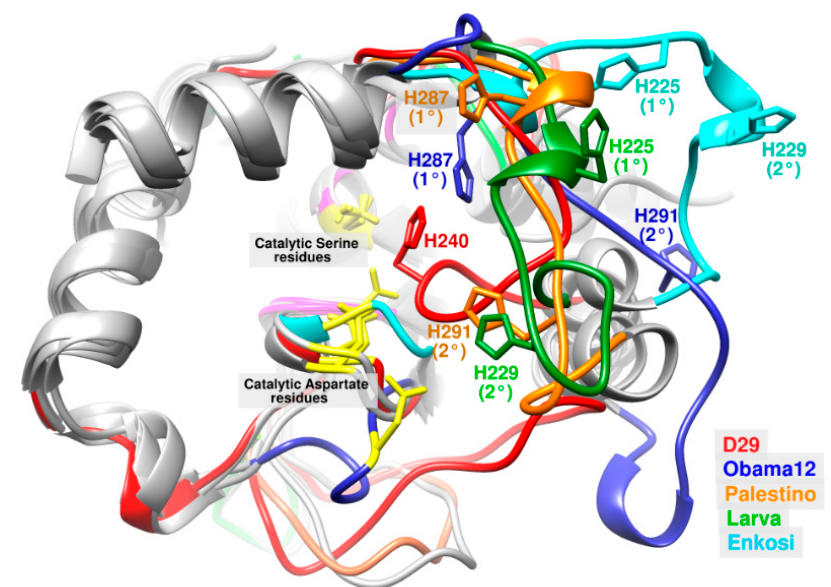
Figure 3. 3D structural alignment of LysB-D29 (red) with LysB-Obama12 (blue), LysB-Palestino (orange), LysB-Larva (green) and LysB-Enkosi (cyan) models with focus on loop-5. The figure shows catalytic Ser and Asp residues (yellow), primary and additional His residues (in each protein color), oxyanion hole, and GNP residues (pink), and the rest of the protein (gray).